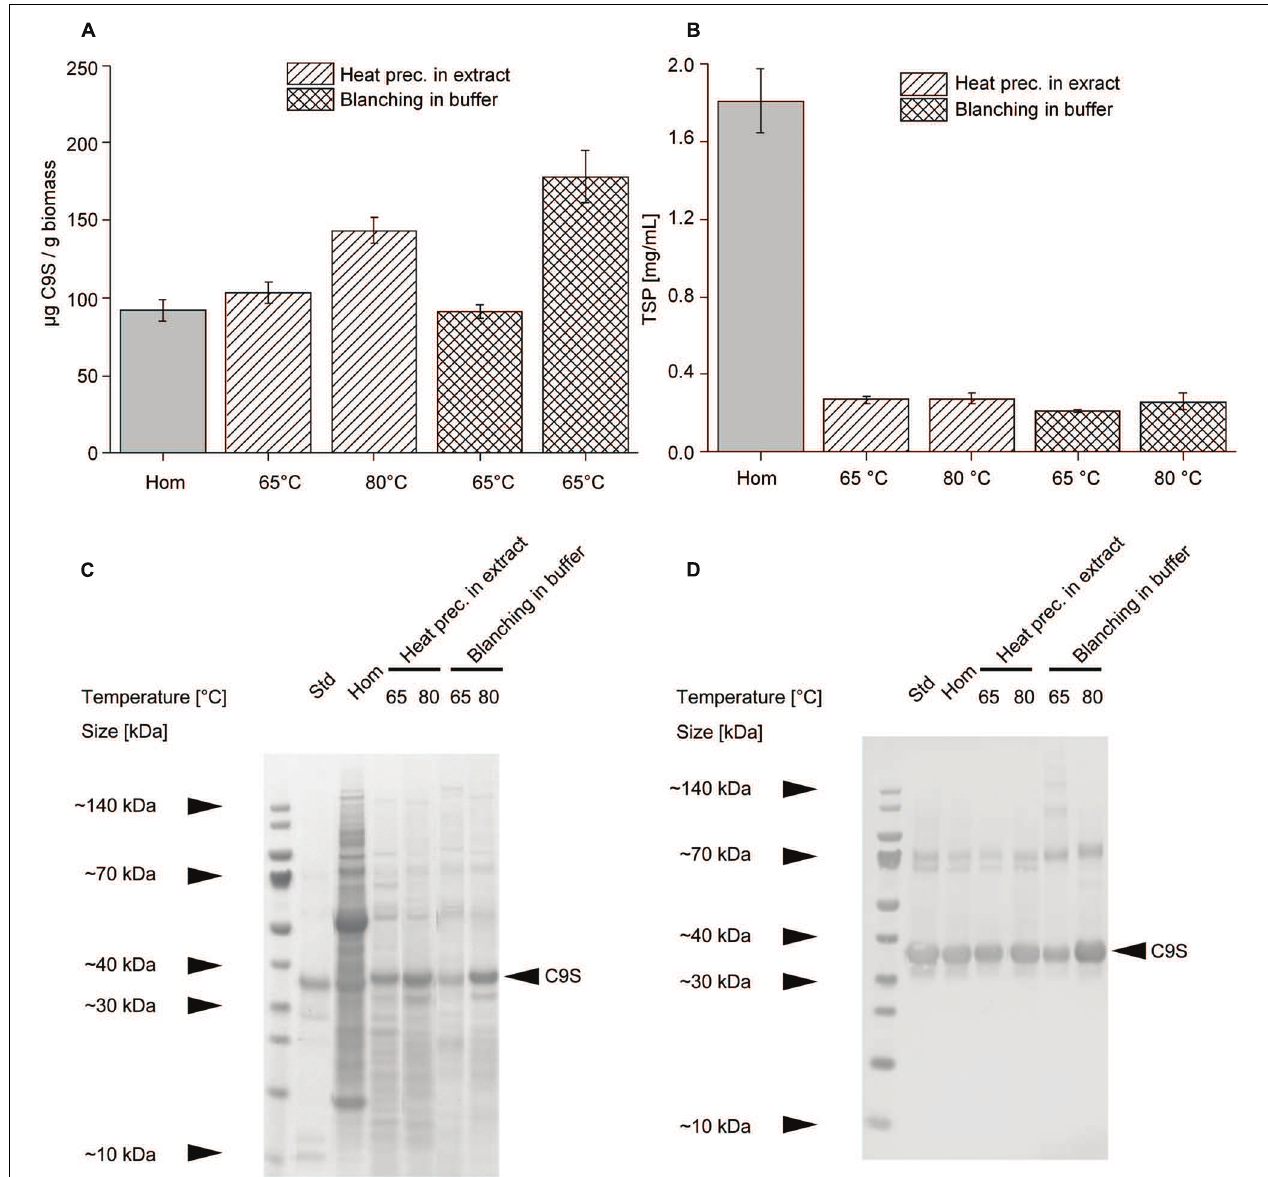
FIGURE 8 | Comparison of blanching in buffer and heat precipitation in the plant extract. The yield of C9S increased for both methods when heat treatment was carried out at 80 ◦ C instead of 65 ◦ C (A) , whereas there was no difference in TSP levels at these temperatures, i.e., both methods achieved a reduction of 85% compared to untreated extract (B) . The increased yields were also observable on Coomassie-stained LDS-PAGE gels (C) and western blots using C9S-specific primary antibody for detection (D) . Hom – homogenate; Std – His 6 -tagged C9S variant, 390 ng per